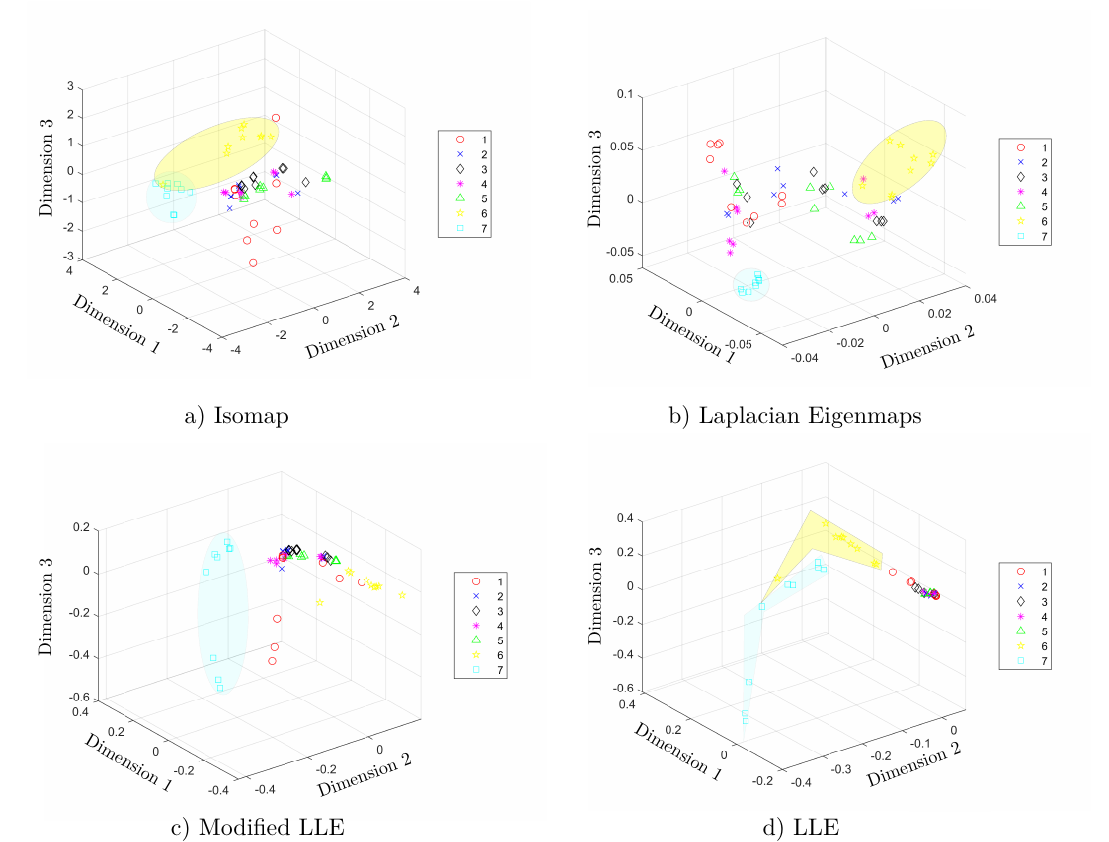
Figure 4. Three dimensional scatter plots after applying ( a ) Isomap; ( b ) Laplacian Eigenmaps; ( c ) Modified Locally Linear Embedding (LLE); and ( d ) LLE. The numbers in the legend refers to the seven classes of aqueous matrices, as follows: red wine (1) white spirit (2), beer (3), black tea (4), oolong tea (5), maofeng tea (6), and pu (cid:48) er tea